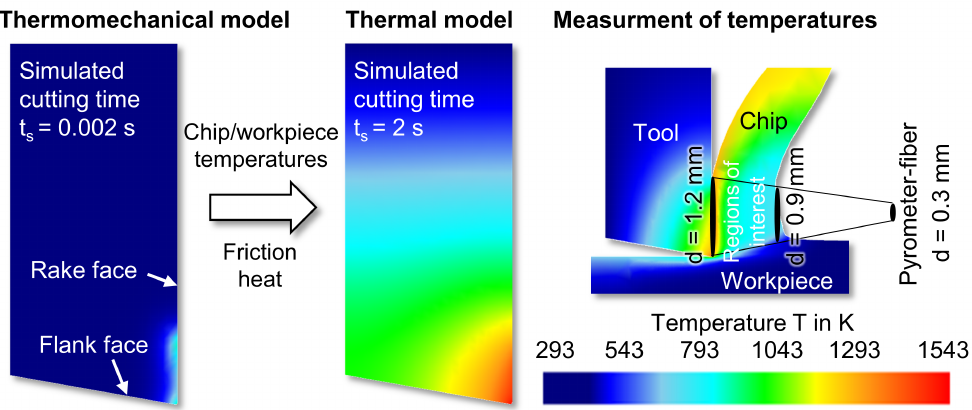
Figure 10. Schematic illustration of the thermomechanical and the thermal FE model with resulting temperature distribution for AISI